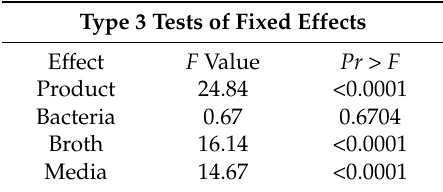
Table 6. Factors influencing the growth of bacteria using the neutralizer